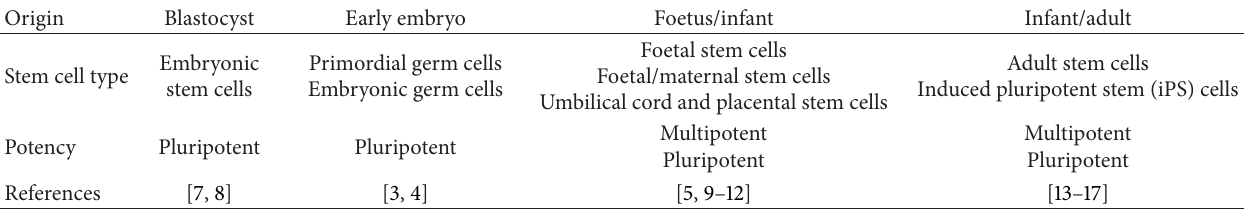
Table 1: Stem cell types, their origin, and their differentiation